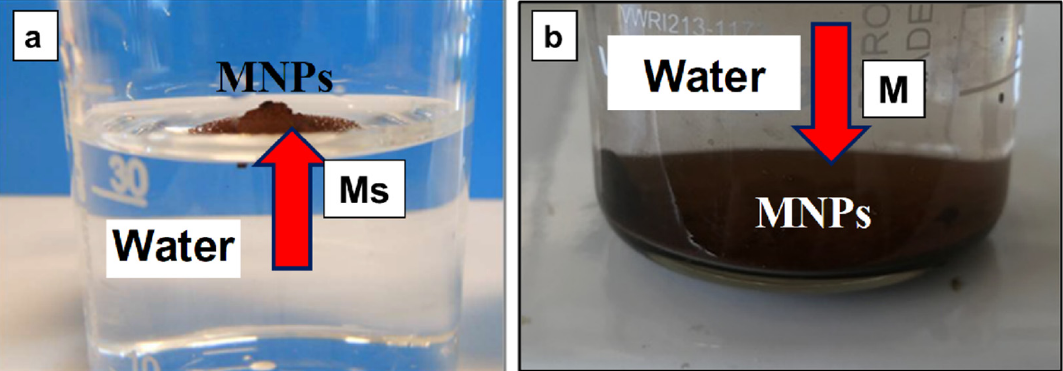
Figure 4. ( a , b ) Evidence of the properties of hydrophobicity following the immersion in water of ( a ) surface treated magnetite with MHX compared with ( b ) the pristine nanofiller (hydrophilic). Abbreviations: MNPs = magnetite nanoparticles; M and Ms are the symbols for untreated and surface treated magnetite nanofiller, respectively.